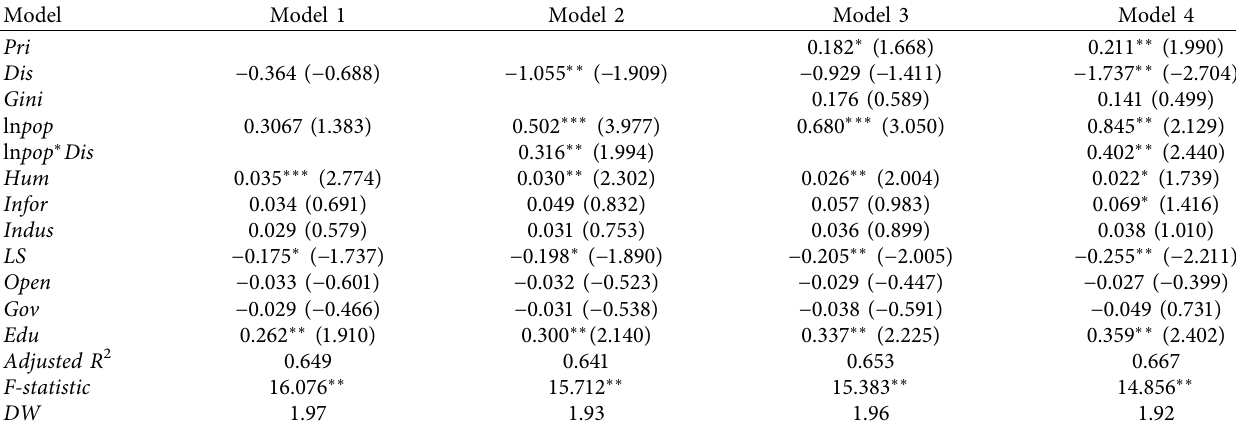
Table 10: Regression results of impact of spatial structure on economic